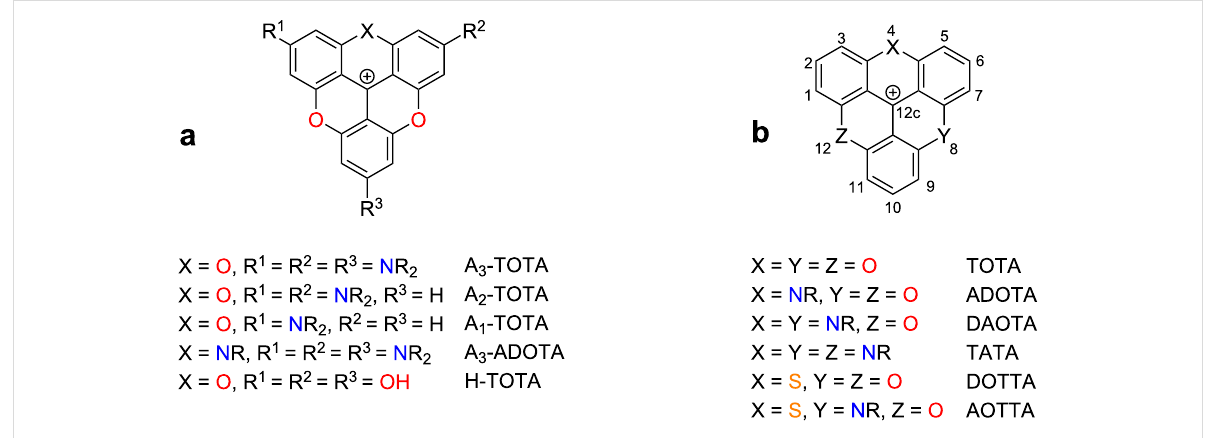
Figure 1: Structures of some representative triangulenium dyes. a) Rhodamine/fluorescine-like derivatives with donor groups in para -positions (2, 6, and 10) to the formal cation center (12c). b) Derivatives without donor groups.